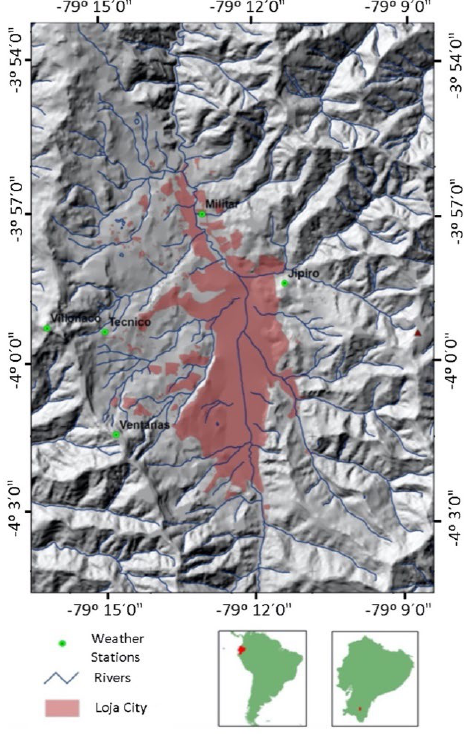
Figure 1. Location of study area.